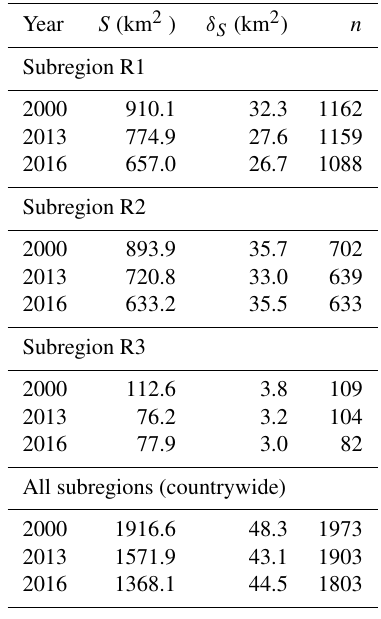
Table 1. Measured glacier extents for different years and